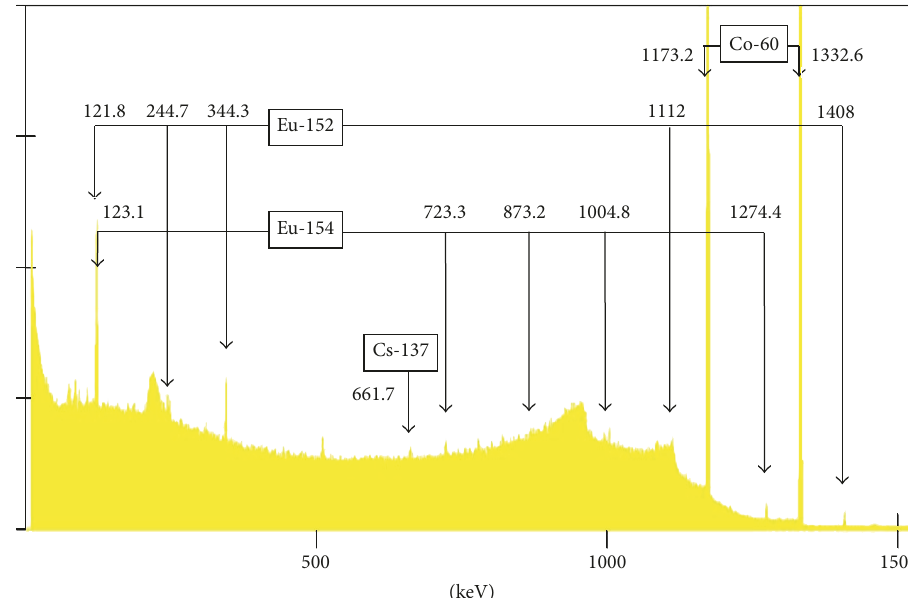
Figure 5: The multichannel 𝛾 spectrum of the irradiated graphite sphere.